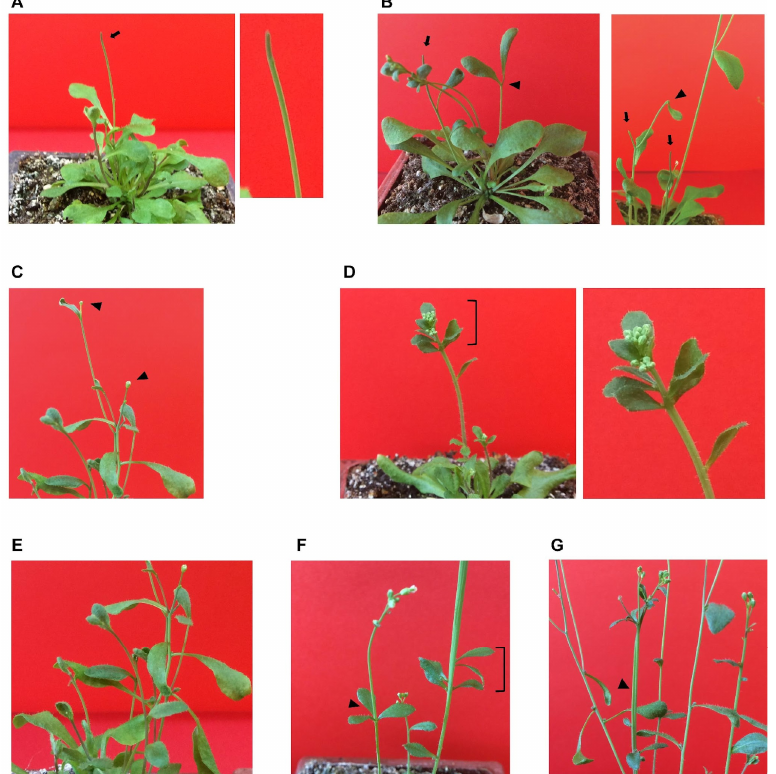
Figure 5. Phenotypic alterations observed in double homozygous plants with drastic reduction of MIT expression. ( A ) A pinoid stem (arrow) with the corresponding enlarged view. ( B ) Two plants with stems terminated at cauline leaves (arrowheads) and which also have pinoid stems (arrows). ( C ) A plant with stems terminated at unique flowers (arrowheads). ( D ) Multiple floral buds and cauline leaves at stem tip. ( E ) Higher number and irregular appearance of cauline leaves. ( F ) Three cauline leaves at the same position (arrowhead). ( G ) Enlarged stem